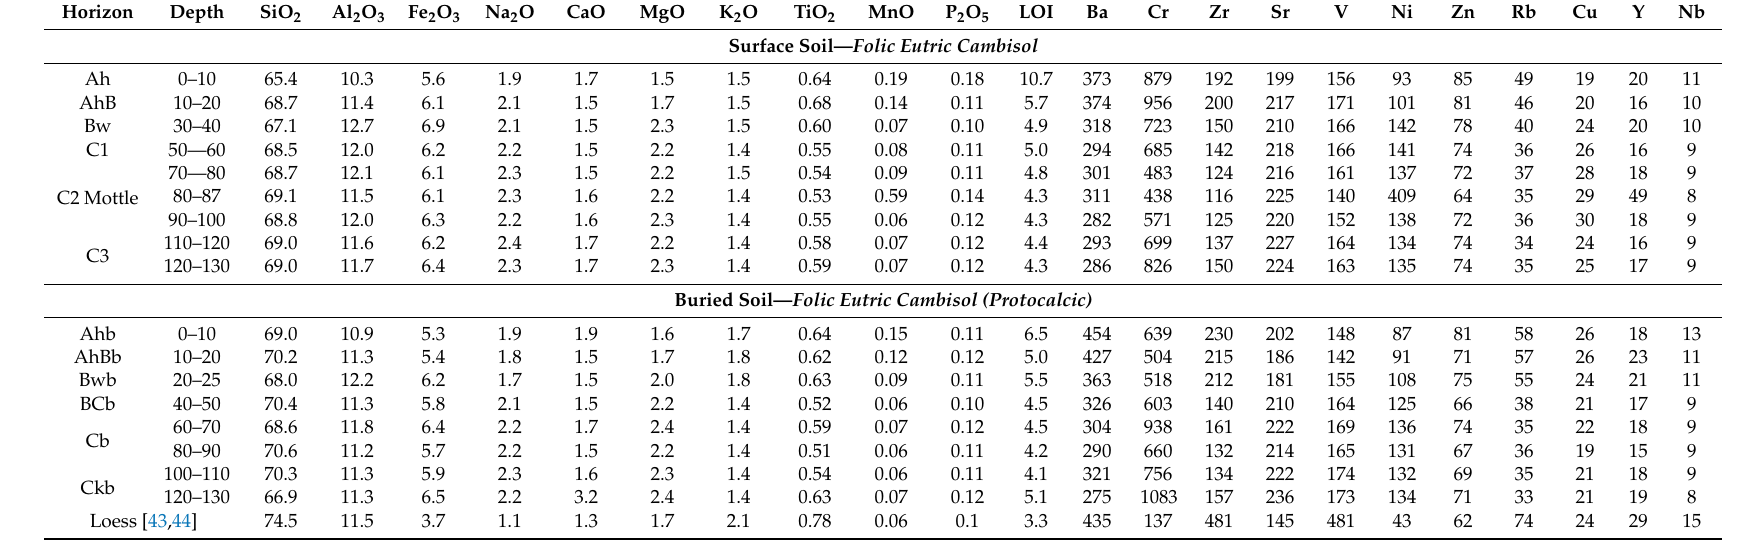
Table 4. Total concentrations of major oxides, loss on ignition (LOI) % and trace elements concentrations (mg · kg − 1